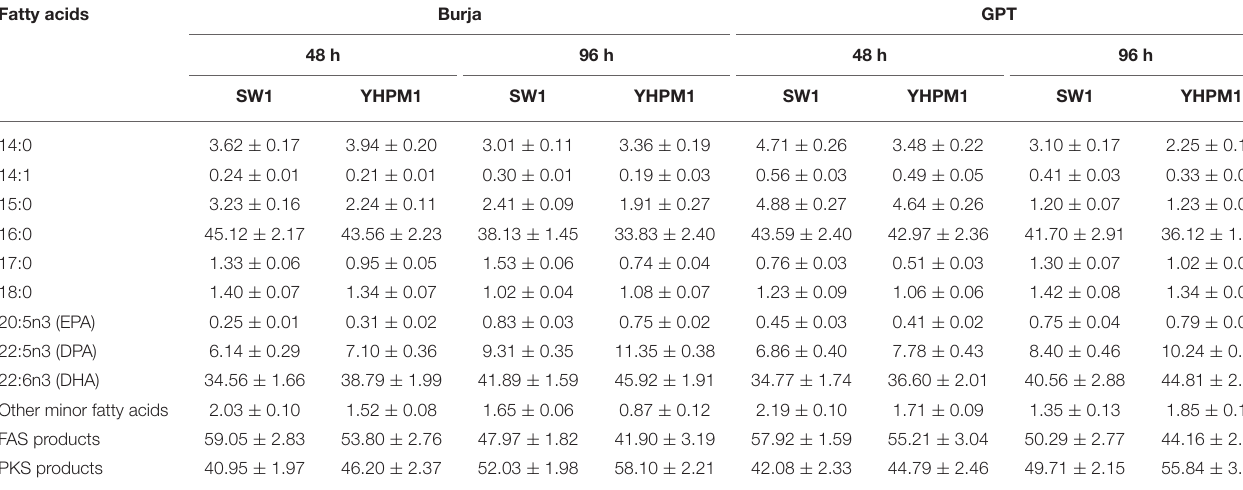
Values represent the means of triplicate experiments (n =